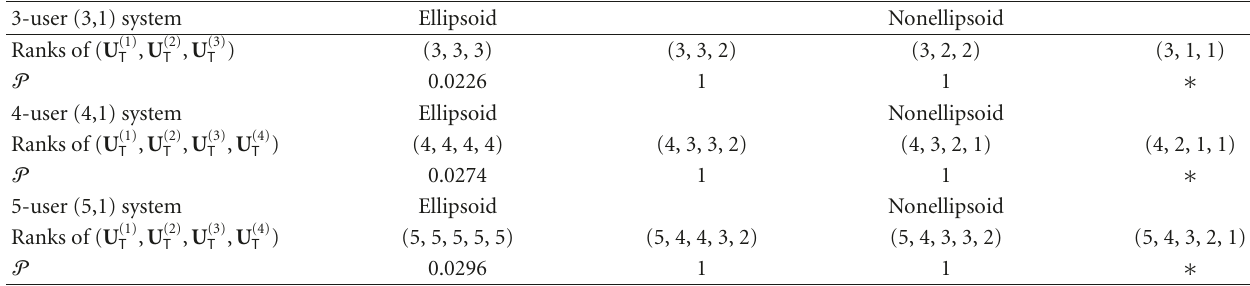
Table 3: The probability, P , that the proposed algorithm (22) does not give an all-rank-1 solution. In this table, ∗ means that (22) does not even have a feasible solution. 3-user (3,1)